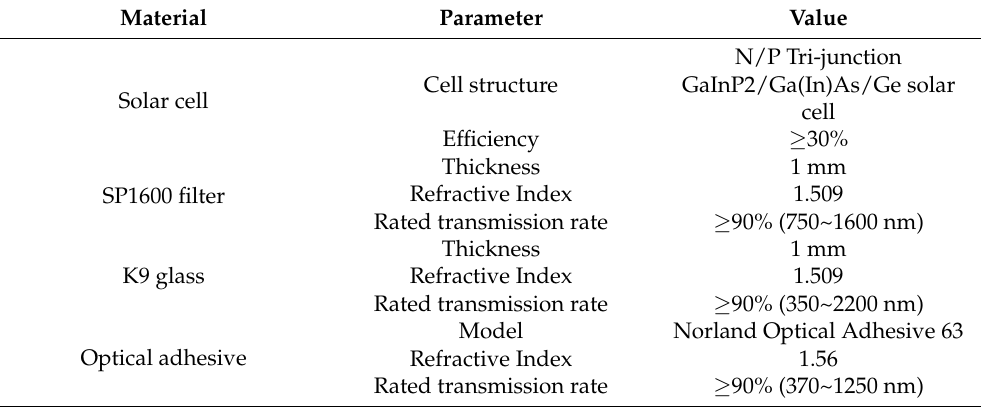
Table 5. Materials and parameters used in the test.